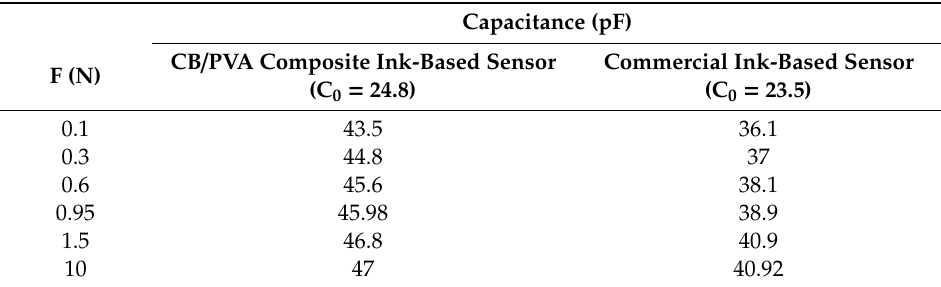
Table 3. Capacitance values observed at the touch of a finger with di ff erent